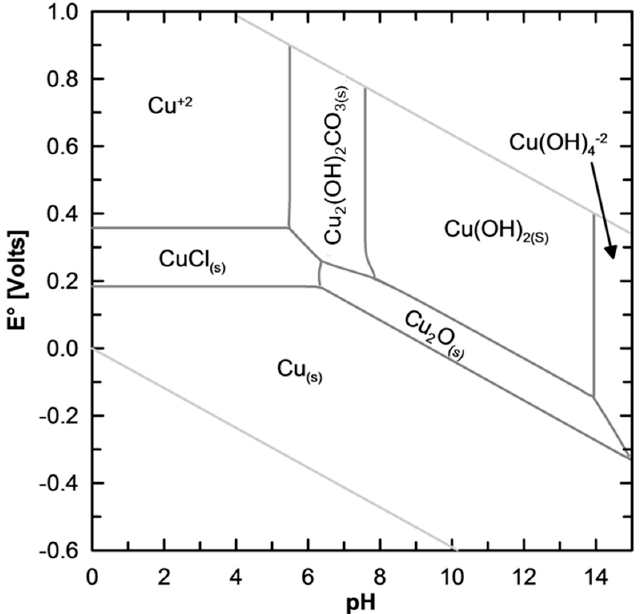
Figure 3. Pourbaix diagram of copper species for a closed system Cu-Cl-CO 3 . Calculations made considering Cu TOTAL = 10 − 5 M, Cl TOTAL = 8 × 10 − 2 M, CO 3 TOTAL = 10 − 3 M.